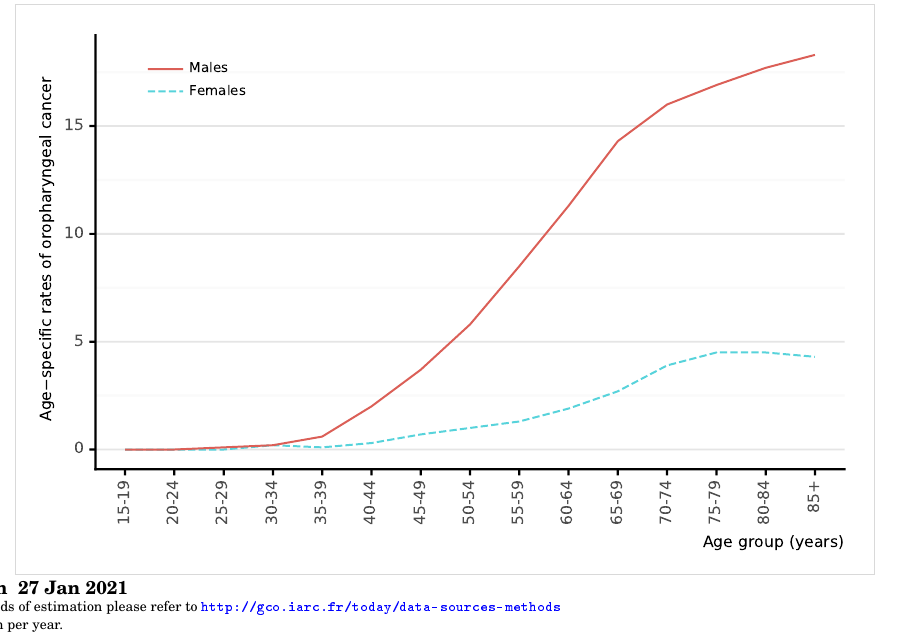
Figure 36: Age-specific incidence rates of oropharyngeal cancer in India (estimates for 2020)